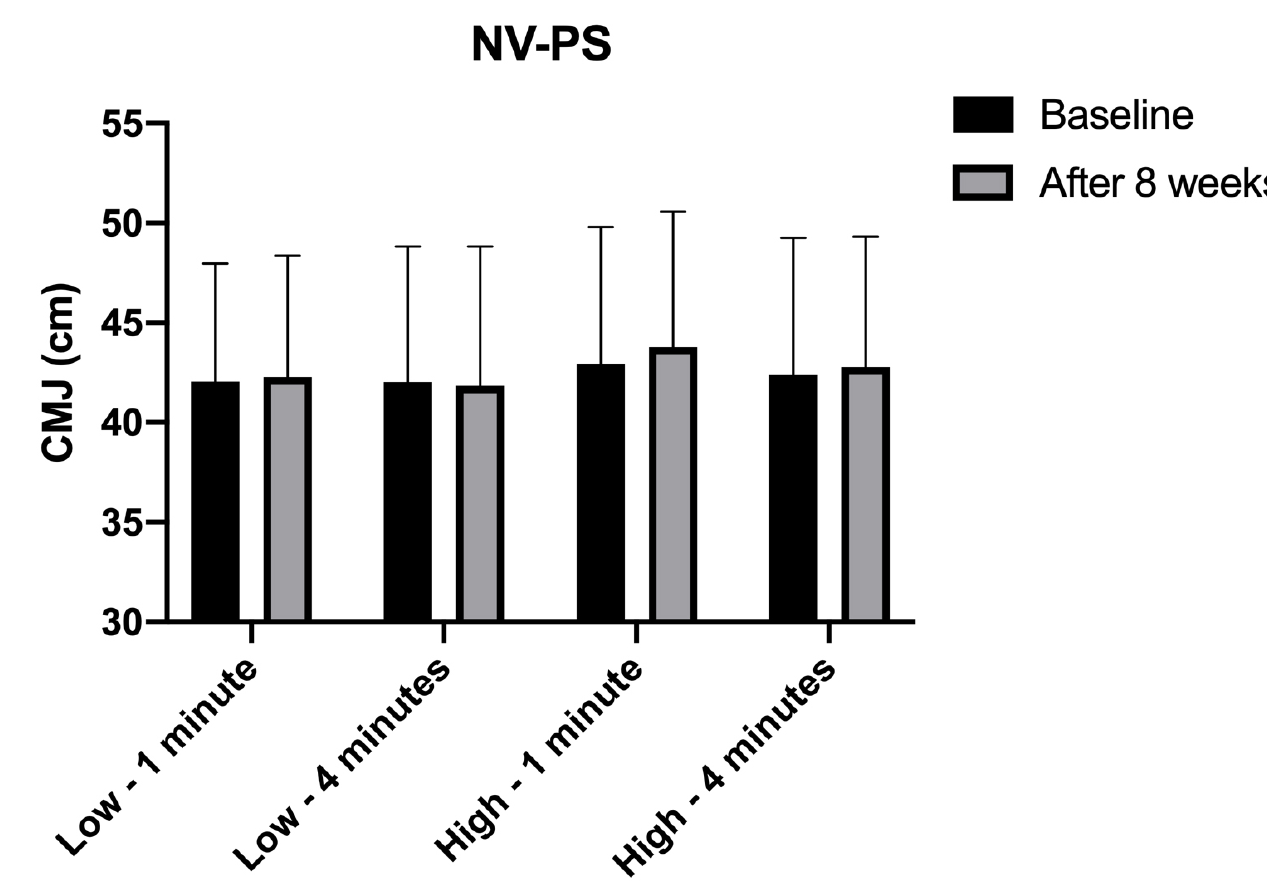
FIGURE 2. Differences between baseline and after post-activation potentiation protocols in terms of volume and rest duration for countermovement jump (CMJ) in parallel squat without vibration